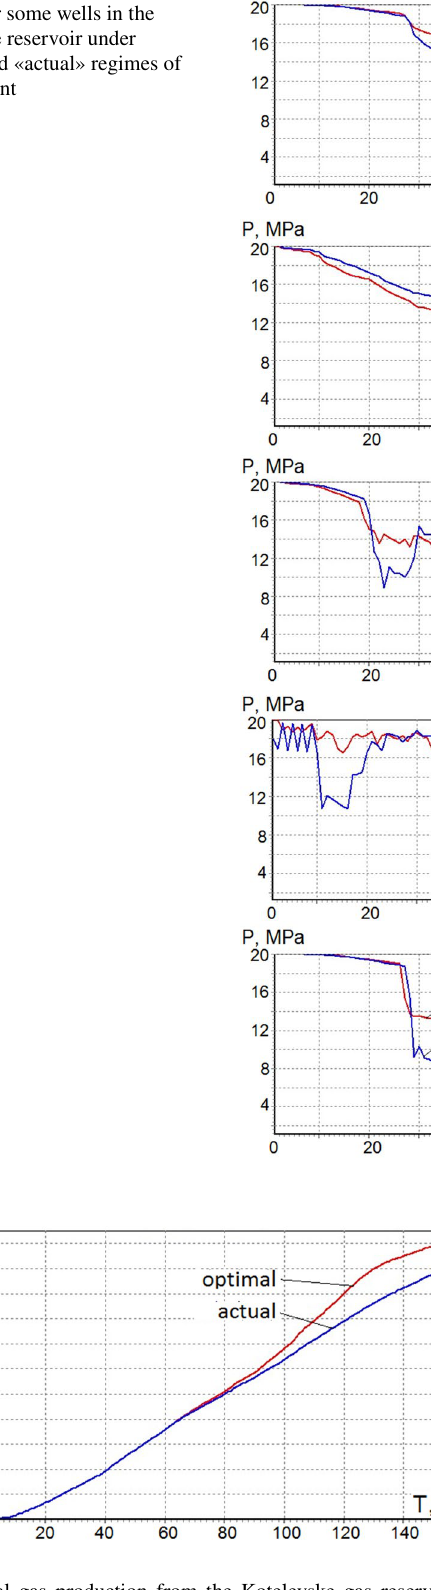
Fig. 3 Pressure dependence on time for some wells in the Kotelevske reservoir under optimal and «actual» regimes of development